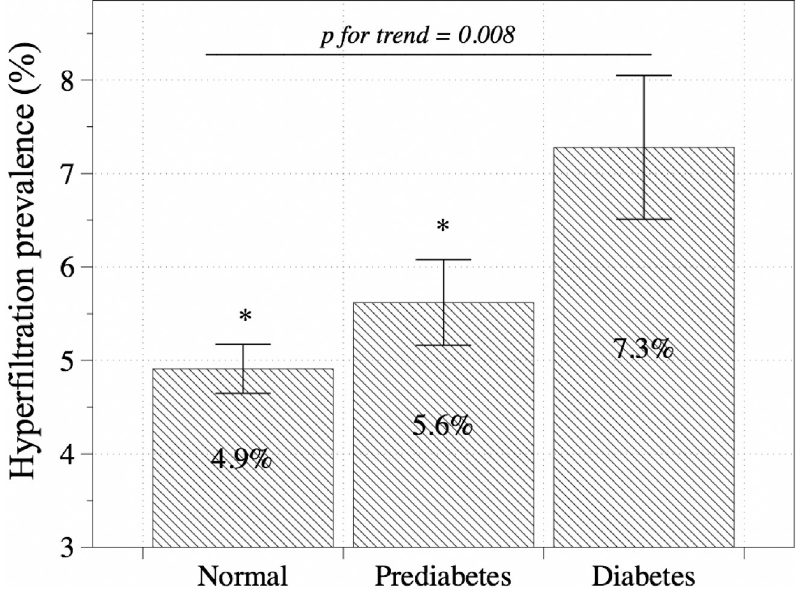
Fig 1. Prevalence of hyperfiltration assessed by status of glucose tolerance. This sample was restricted to subjects older than 18 years who were not pregnant and had no apparent chronic kidney disease. The error bars represent the 95% confidence intervals. � P < 0.05 vs. Diabetes group (Bonferroni method).